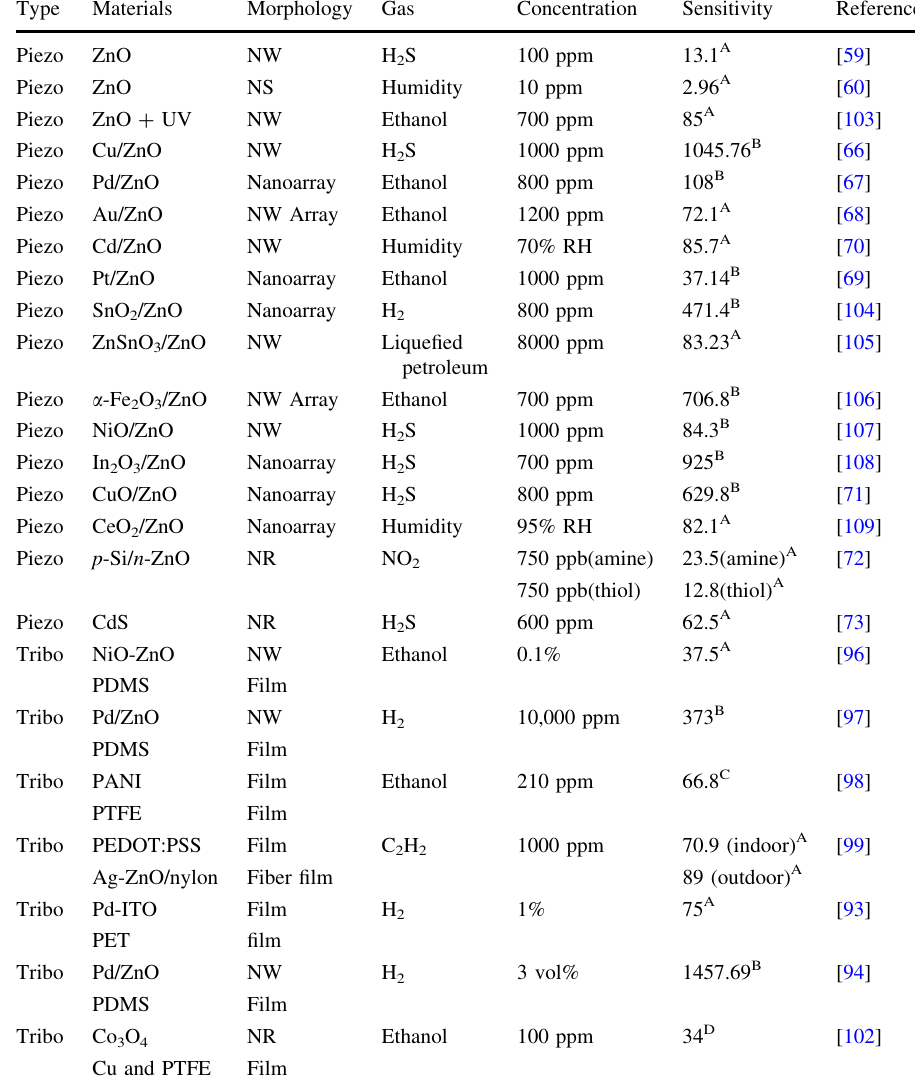
Table 1 A summary of various NG-based self-powered gas